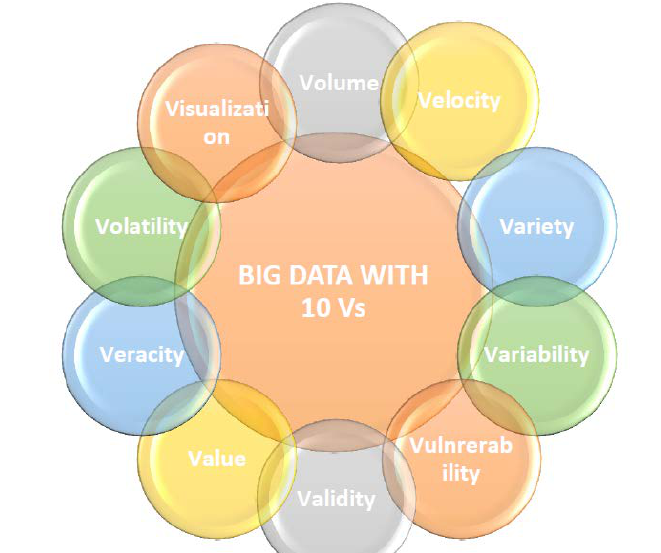
Figure 1. Schematic Representation of Big Data in terms of 10